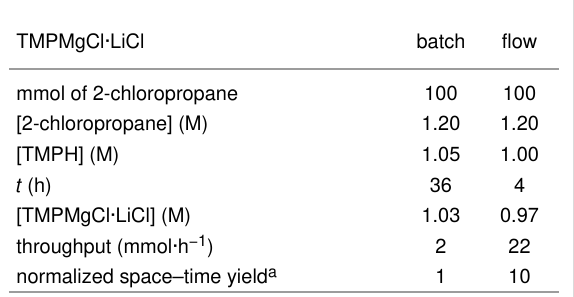
Table 4: Reaction between amines and isopropylmagnesium chloride generated in situ. Knochel–Hauser bases synthesis using a stratified packed-bed column of activated magnesium and lithium chloride. a